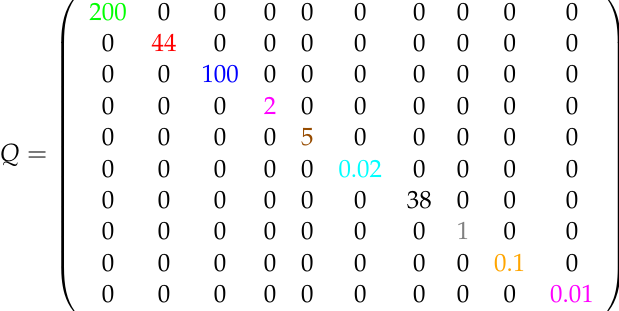
With this included in the MPC algorithm, the result of the following scenario is shown in Figure 3. In this figure and the subsequent ones, the dashed lines in panel A correspond to the nominal desired terminal for each vehicle. The dashed lines in panel B denote the maximum charging currents for each vehicle model.